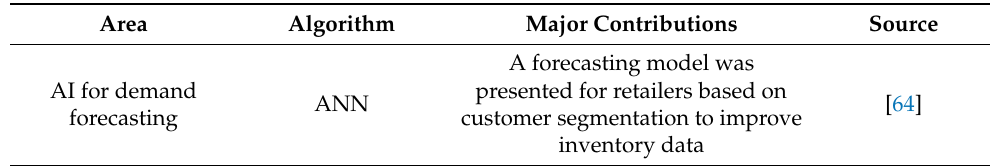
Table 2. Functional AI technologies in Food